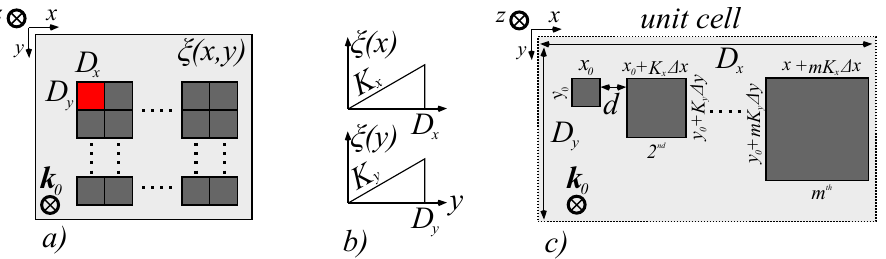
Figure 2. Structure of the patch-based metasurface. ( a ) Top view of the interface made of unit cells with dimensions D x and D y (pictured in red) aligned parallel to the xy axis set. ( b ) Schematic of the phase function along the x and y axes for one unit cell. ( c ) Top view of the unit cell implementing a constant phase gradient on Ox , consisting of an array of 1 × m array of patches having linearly increasing sizes ∆ x and ∆ y